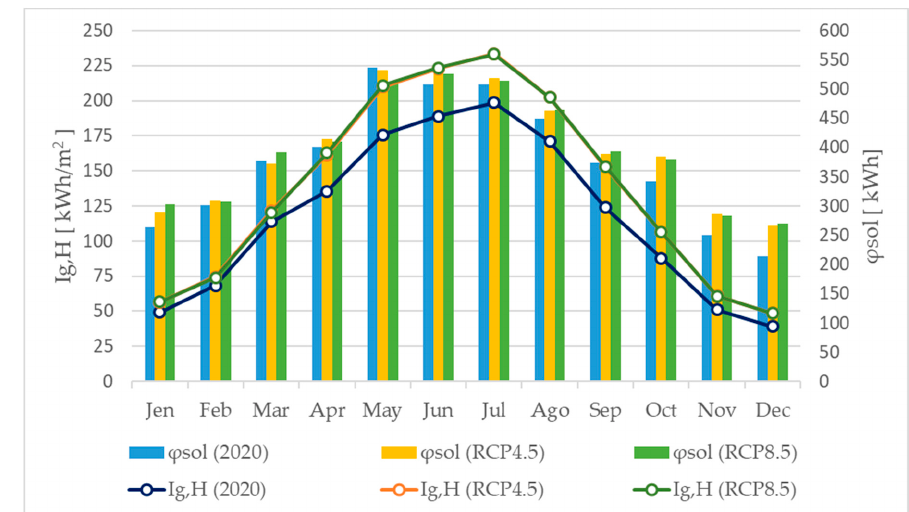
Figure 4. Monthly sum of solar gains ( φ sol) and solar global irradiance on the horizontal plane (Ig,H) for 2020, 2050 (RCP4.5) and 2050 (RCP8.5).